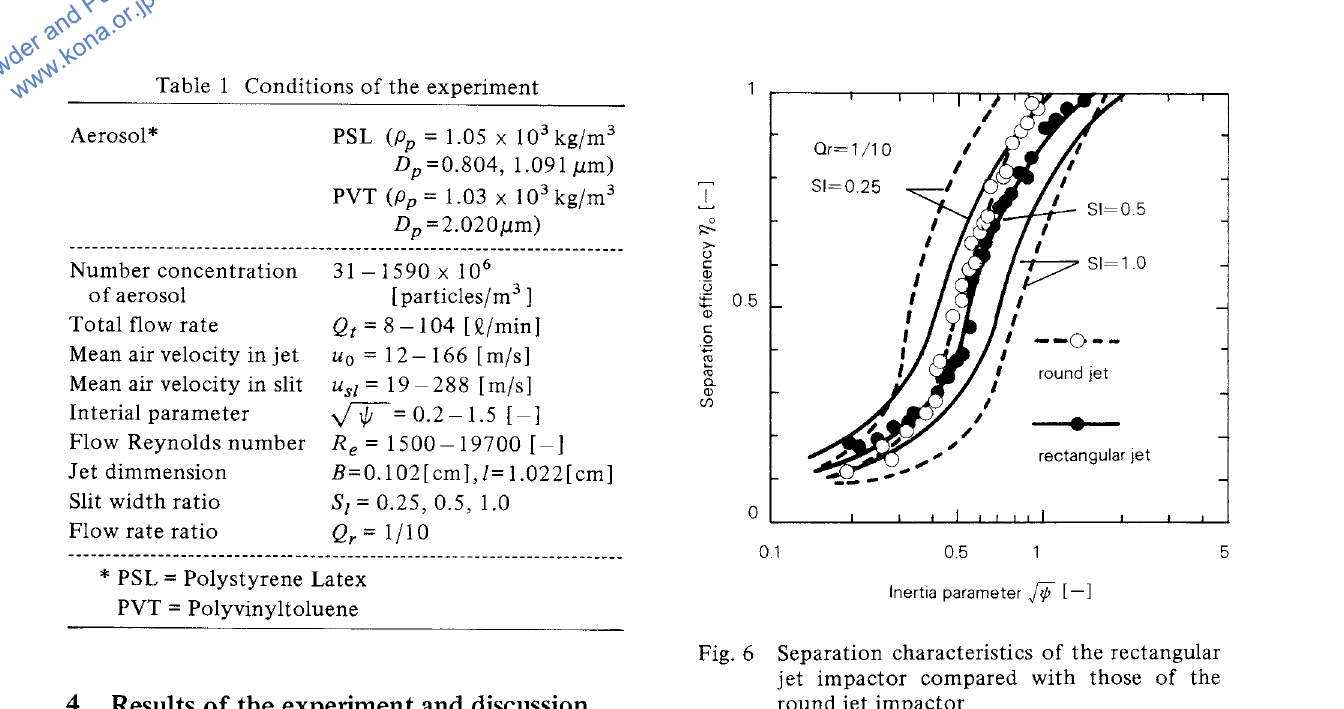
Fig. 6 Separation characteristics of the rectangular jet impactor compared with those of the round jet impactor